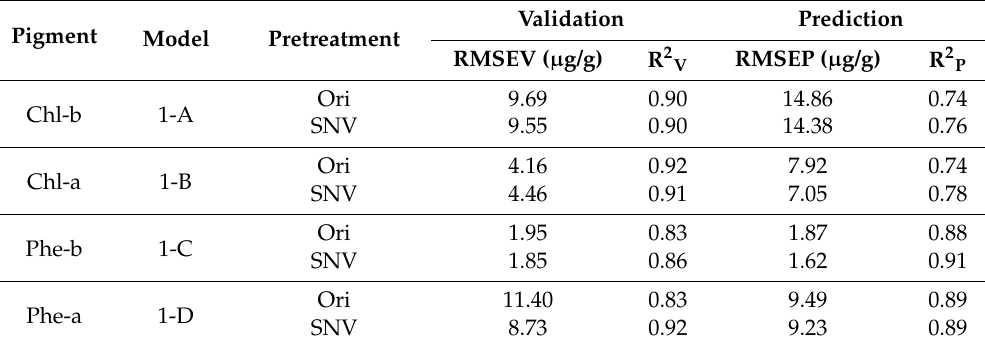
Table 2. The PLS model results based on pretreatment methods.